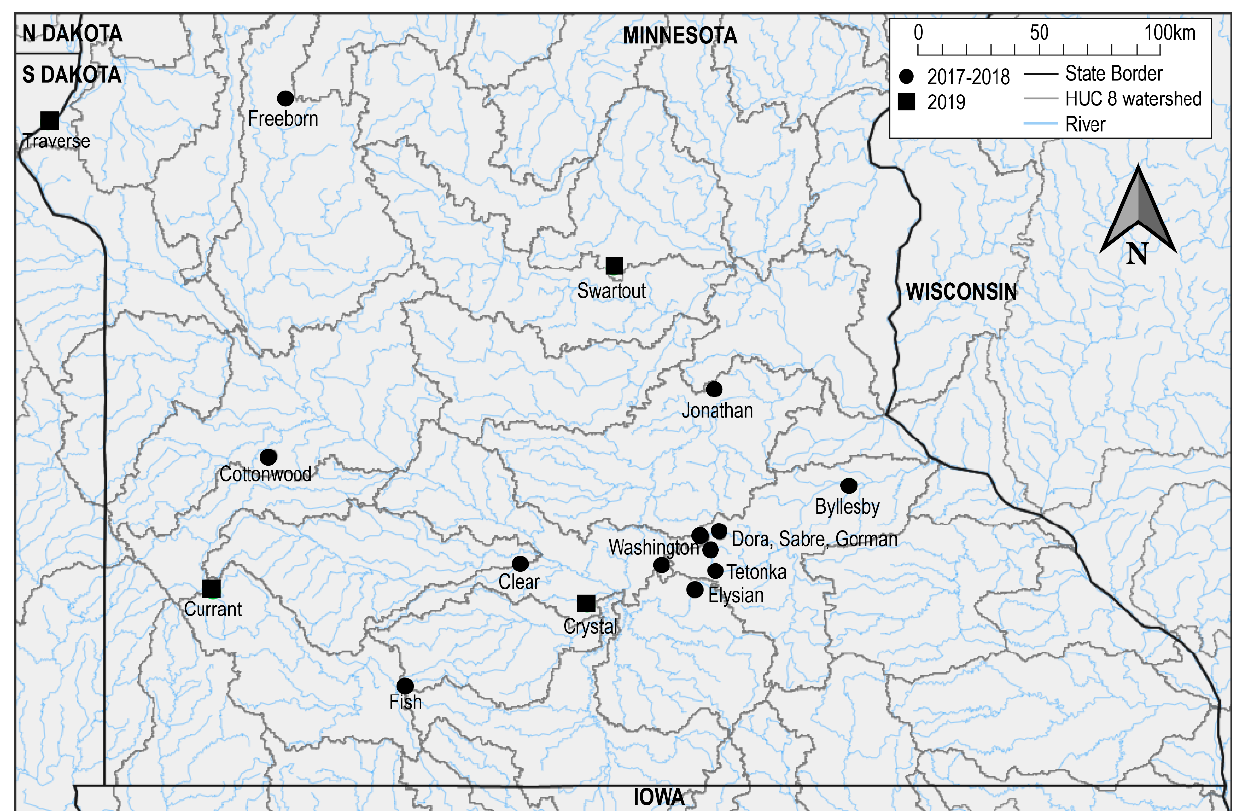
Figure 2. Map of mass mortality events of wild carp in Minnesota associated with CEV or CEV+KHV. Minnesota lakes screened in 2019 (this study) are denoted by black boxes, previously reported mortality events by Padhi et al. 2019 [9], are denoted by black circles. State boundaries, HUC 08 level watersheds, and major rivers are indicated by black, gray, and blue lines, respectively.